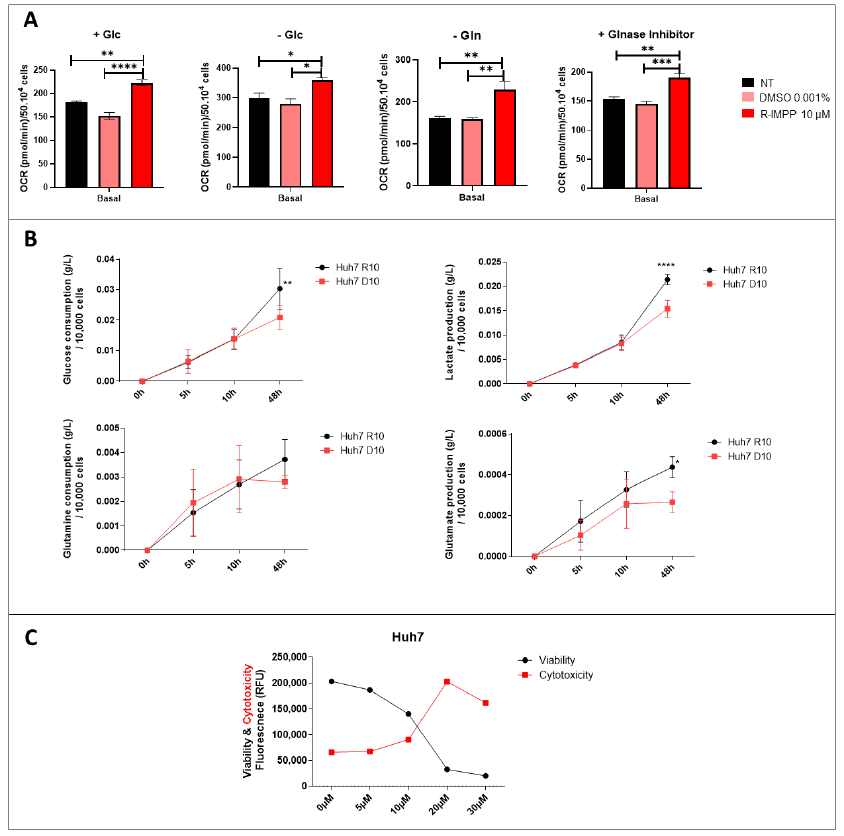
Figure 4. Effect of inhibition of PCSK9 on mitochondrial respiration and metabolic pathways. ( A ) OCR was evaluated by the Seahorse assay in Huh7 cells, which were incubated in different media settings, as indicated. NT: non-treated. * Ordinary one-way ANOVA test. ( B ) Glucose and glutamine consumption as well as lactate and glutamate production by Huh7 cells treated with R-IMMP (10 µM) vs. DMSO (D10) were measured at different time intervals. * Two-way ANOVA test. * p < 0.05; ** p < 0.01; *** p < 0.001; **** p < 0.0001. ( C ) Viability and cytotoxicity were measured by ApotoxGlo™ Assay in Huh7 cells treated with different doses of R-IMPP for 48 h (n = 1).